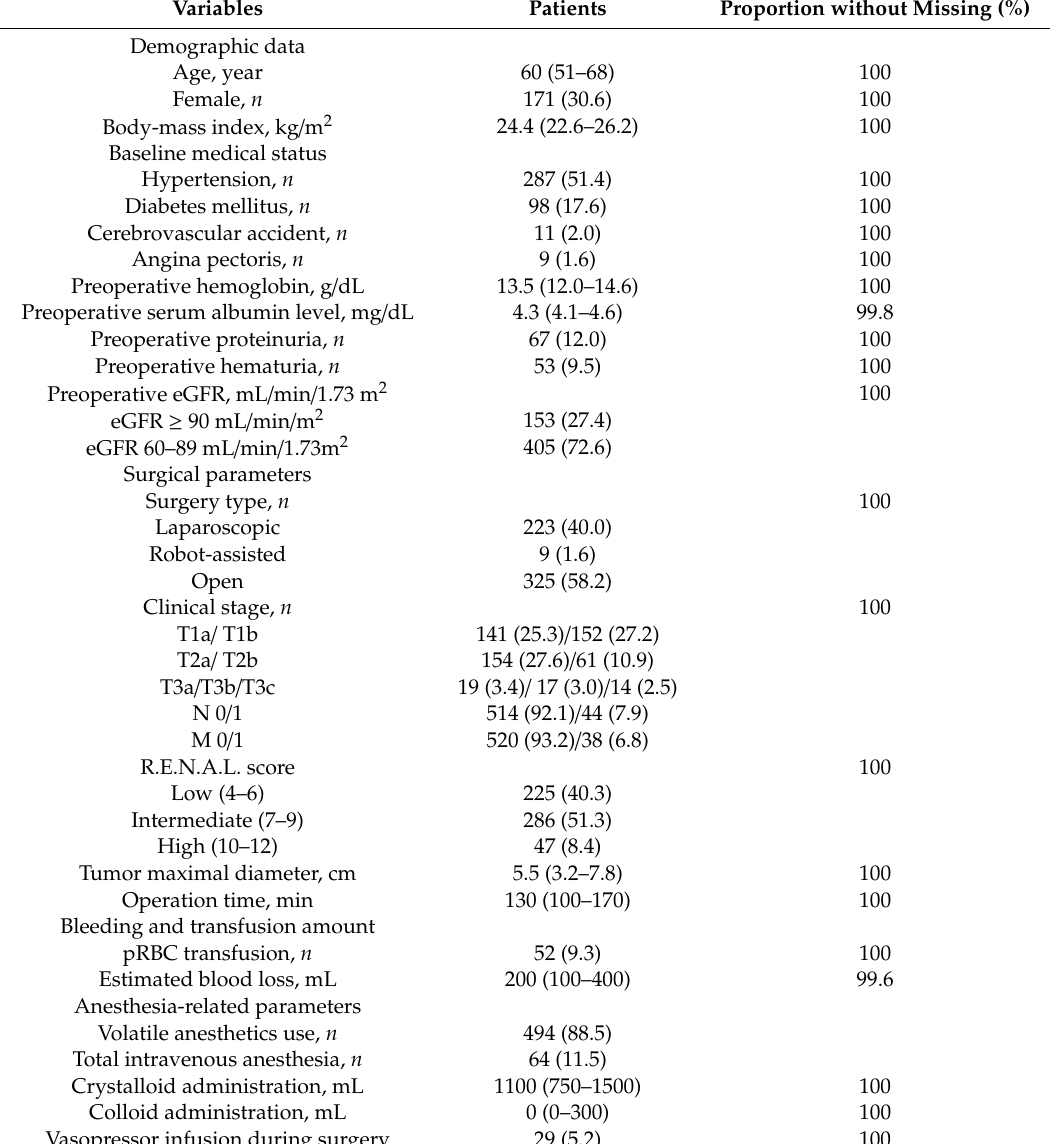
Table 1. Patient characteristics and perioperative parameters according to acute kidney injury ( n = 558).